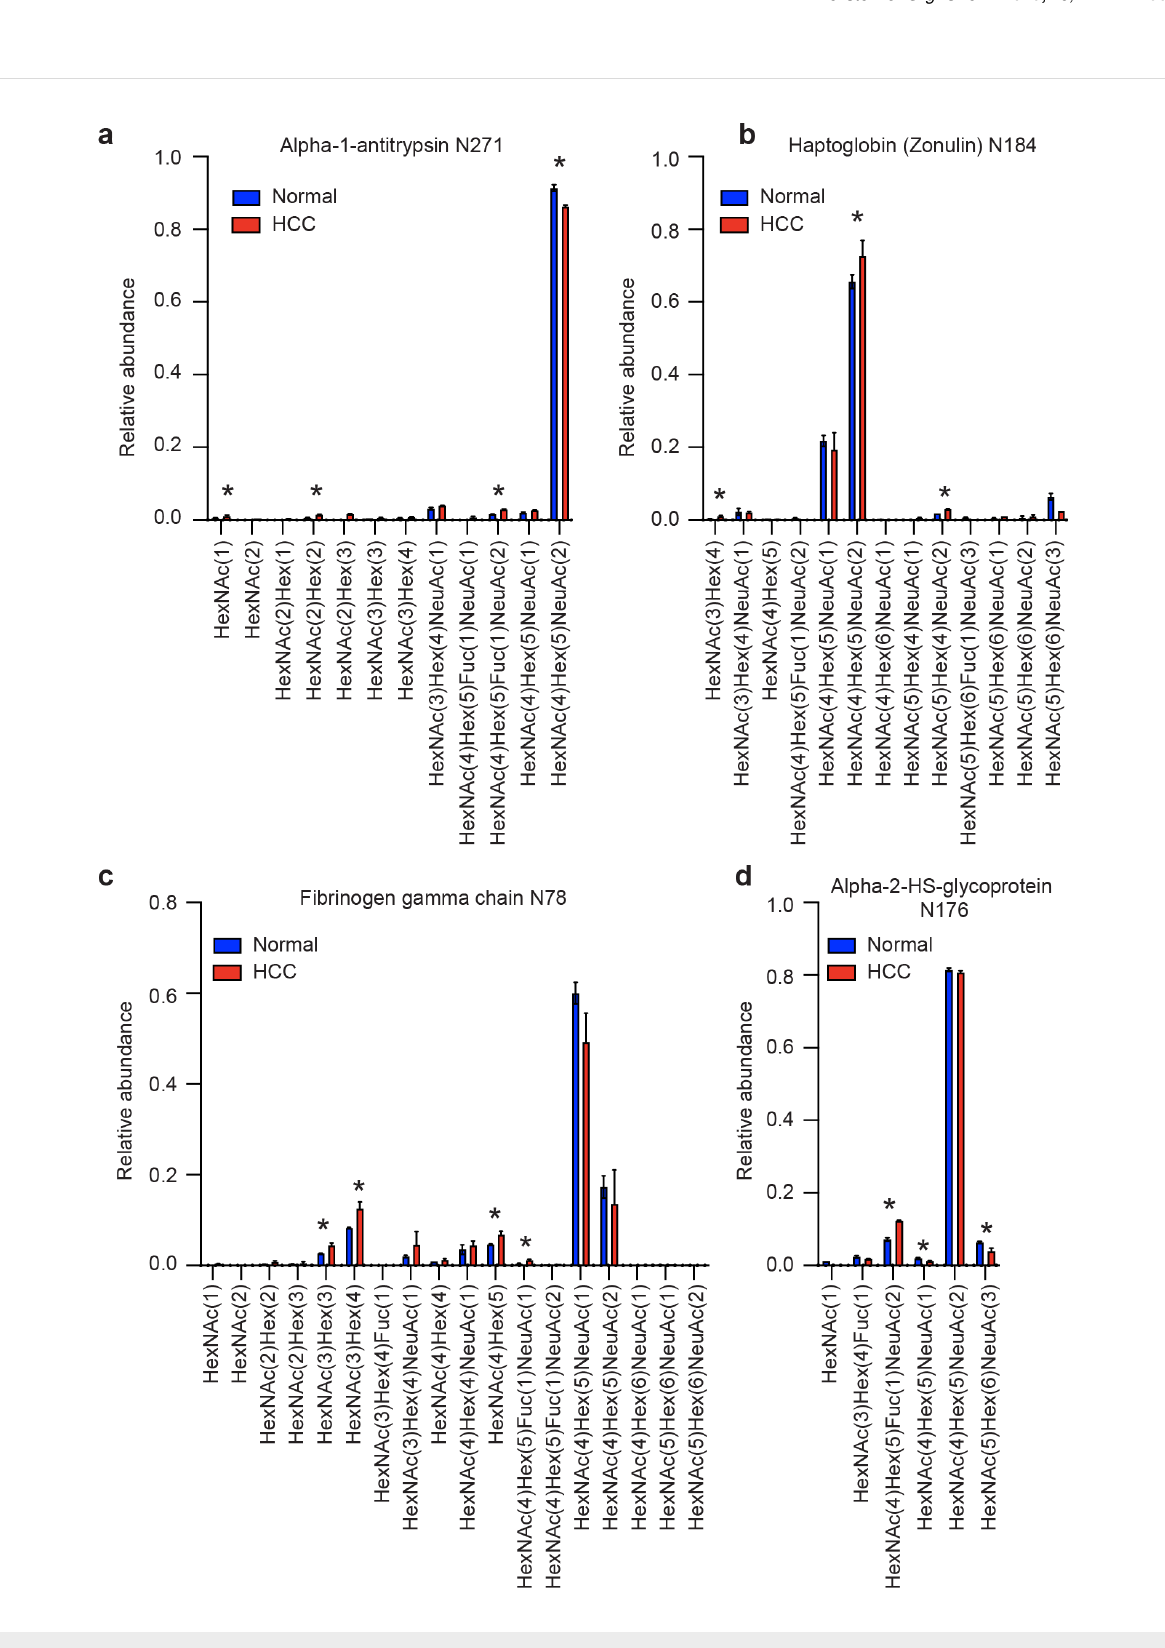
Figure 3: Site-specific N -glycopeptide profiling with GlypNirO. Site-specific relative glycoform abundance in HCC patients and healthy controls at (a) alpha-1-antitrypsin N271, (b) haptoglobin N184, (c) fibrinogen gamma chain N78, and (d) alpha-2-HS-glycoprotein N176. N = 3; values show mean; error bars show standard error of the mean; *, P <